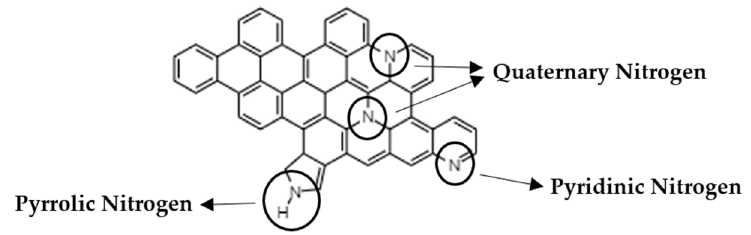
Figure A10. TEM micrograph of ZIF-67 carbonized at 900 °C and washed two times.